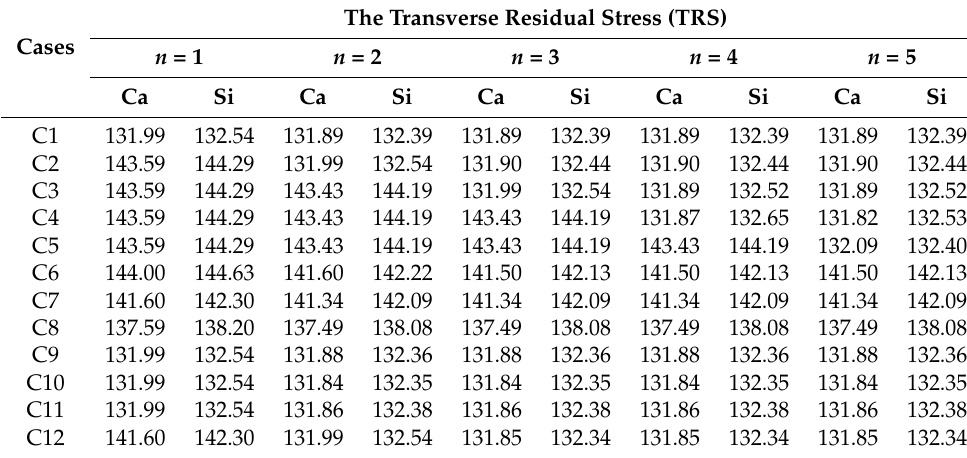
Table 5. Comparison of simulation (Si) and calculation (Ca) values of transverse residual stress under variable-amplitude cyclic loading cases (unit: